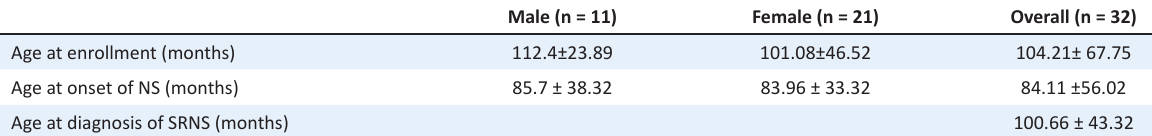
Table 1. Average age at onset of NS, diagnosis of SRNS and age at enrollment ± SD (in months)